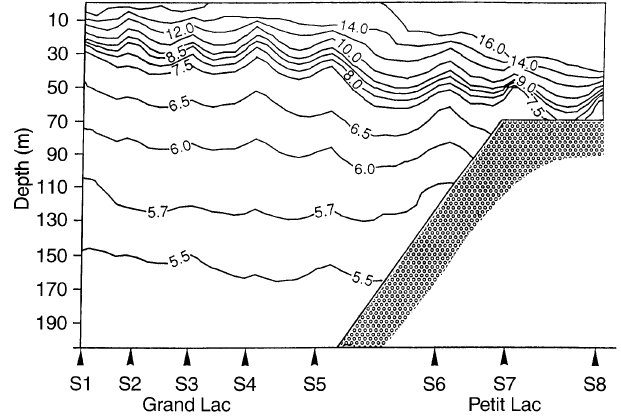
Fig. 9. Isotherm pattern resulting from a NE wind on 4 July 1989. The diagram is constructed from temperature profiles taken at stations indicated on the bottom. For station location see Fig.